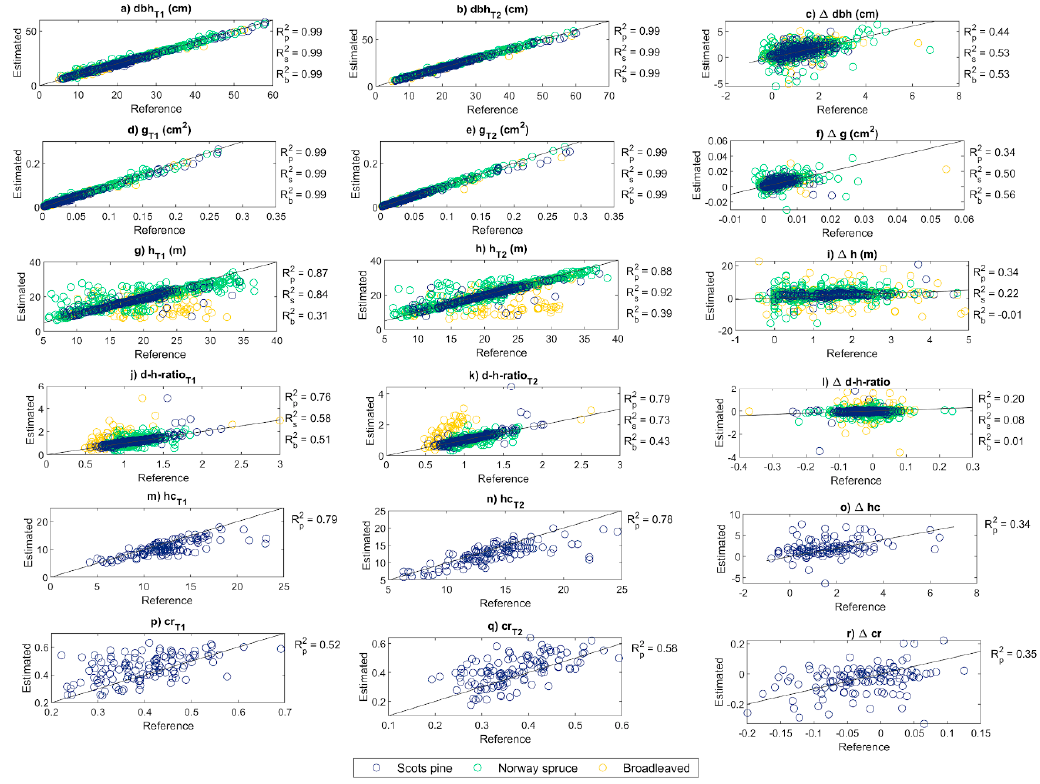
Figure 3. Relationship between the field-measured reference measurements and the TLS-derived estimates on tree attributes, such as diameter-at-breast-height (dbh), basal area (g), tree height (h), diameter-height-ratio (d-h-ratio), and crown ratio (cr) by tree species measured in 2014 (T1) and 2019 (T2) as well as their difference ( Δ dbh, Δ g, Δ h, Δ d-h-ratio, and Δ cr). The solid black line represents the 1:1 relationship between the reference and the estimated values. R 2p , R 2s , and R 2b denote coefficient of determination for Scots pine, Norway spruce, and broadleaved trees, respectively. Table 4. Bias and root-mean-square-error (RMSE) of TLS-derived estimates for tree attributes, namely diameter-at-breast-height (dbh), basal area (g), tree height (h), diameter-height-ratio (d-h-ratio), height of the crown base (hc) and crown ratio (cr) by tree species at time points T1 (2014) and T2 (2019) as well as their change ( Δ ). Negative bias denotes underestimation.